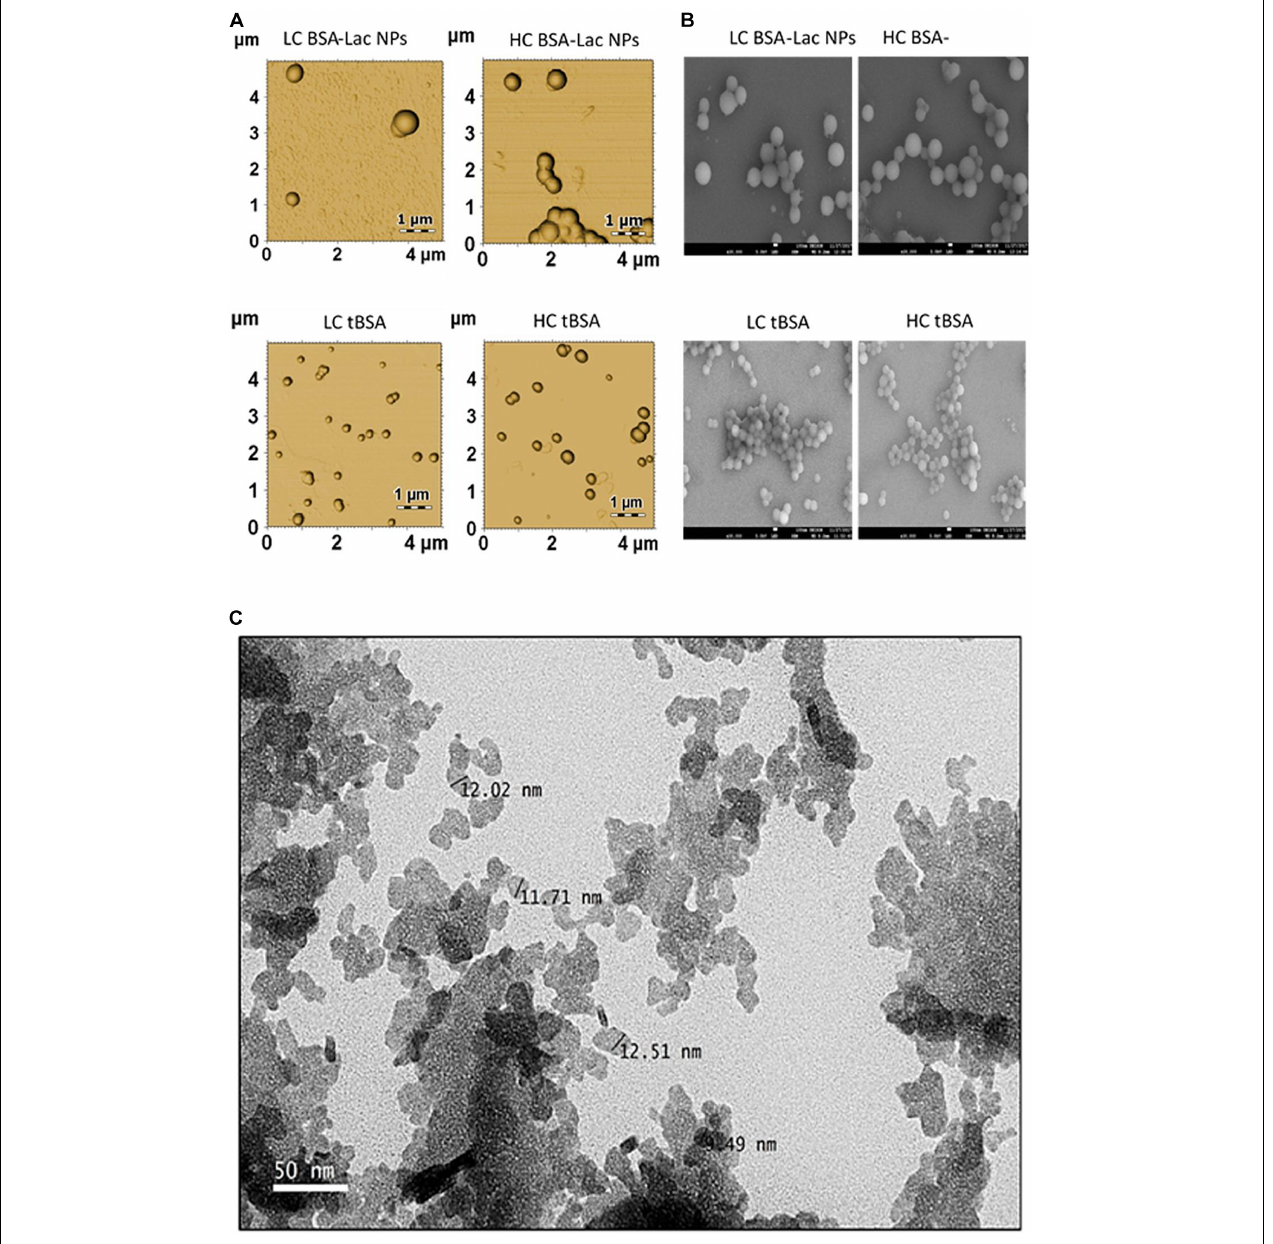
FIGURE 6 | Morphology of HC and LC BSA-Lac and tBSA NPs (A) atomic force microscopy (AFM) and (B) Scanning electron microscopy (SEM). (C) Transmission electron microscopy (TEM) image of Citral-loaded self nano-emulsifying drug delivery system (CIT-SNEDDS). Adapted from Izham et al. (2019) and Teran-Saavedra et al.